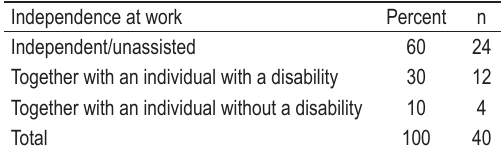
TABLE 9. Communication (manual alphabet and Sign